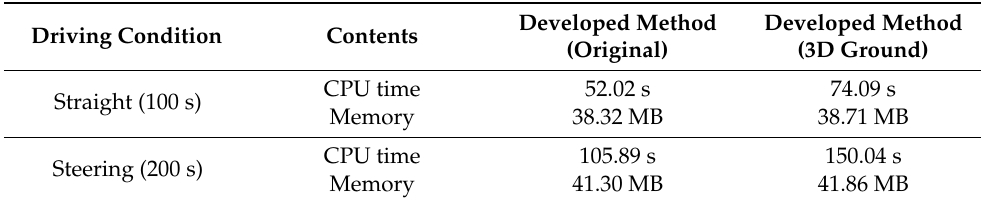
Table 5. Comparison of the dynamic analysis results between the original method of developed program and 3D ground.